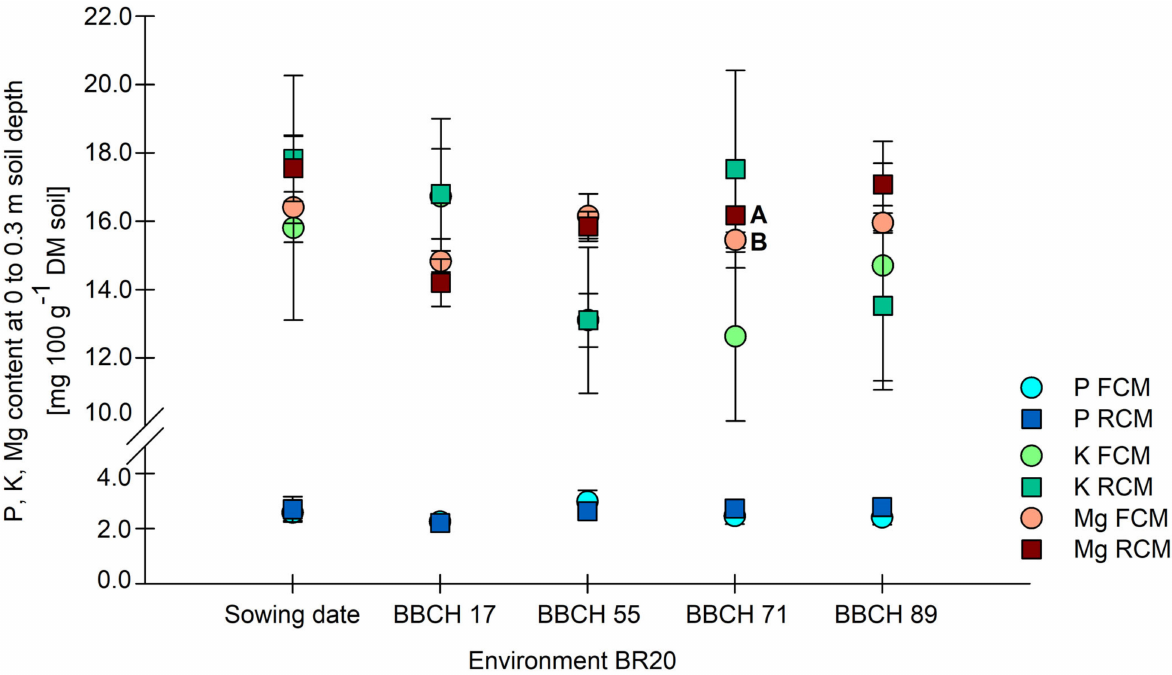
Figure 3. Plant-available phosphorus (P), potassium (K) und magnesium (Mg) content at 0 to 0.3 m soil depth [mg 100 g − 1 dry soil] in FCM and RCM during Environment (En) Bergen 2020 (BR20) for Sowing date, BBCH stages 17 (7 leaves unfolded), 55 (middle of tassel emergence: tassel begins to separate), 71 (beginning of grain development, about 16% dry matter) and 89 (fully ripe). Arithmetic means ± standard error for the respective nutrient element. Tukey–Kramer, different letters (A, B) indicate significance at p < 0.05 for Mg content during BBCH 71 in